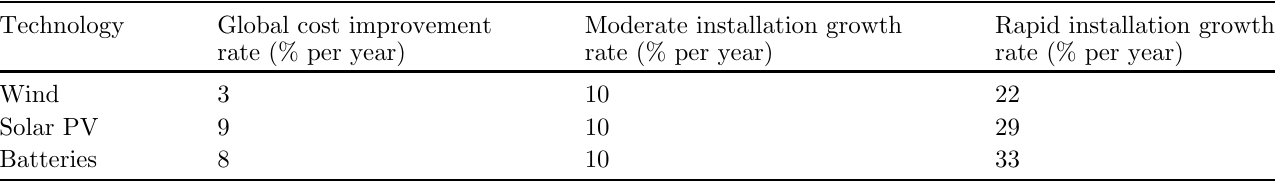
Table 11. Cost improvement and installation growth rates for wind, solar PV and battery